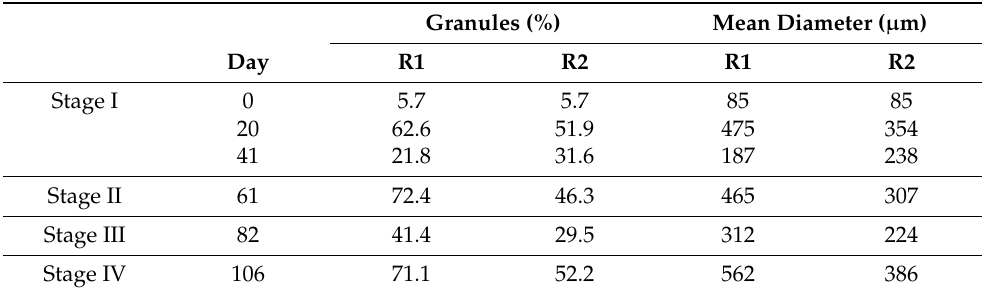
Table 3. Evolution of the granule content and the particle size (quantified in terms of De Brouckere mean diameter) of the sludge samples in each